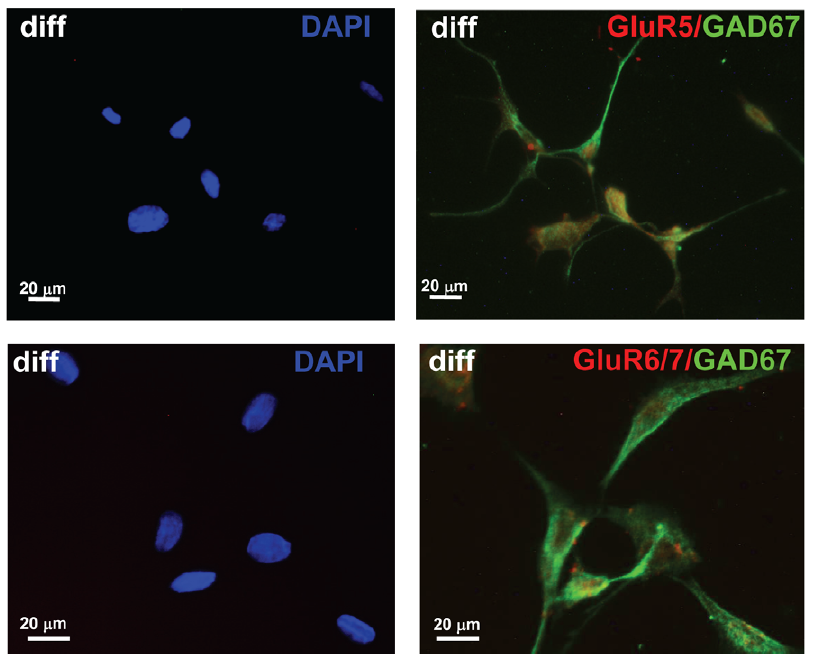
Figure 8. Co-localization of GAD 67 with (A) GluR5 and (B) expression glutamate receptor subunits GluR6/7 in differentiated cells. Specific antibodies were used to detect glutamate receptor subunits. ( A ) GluR5 expression in differentiated HiB5 cells; ( B ) GluR6/7 expression in differentiated HiB5 cells. GluRs (red) was co-localized with GAD 67 (green).